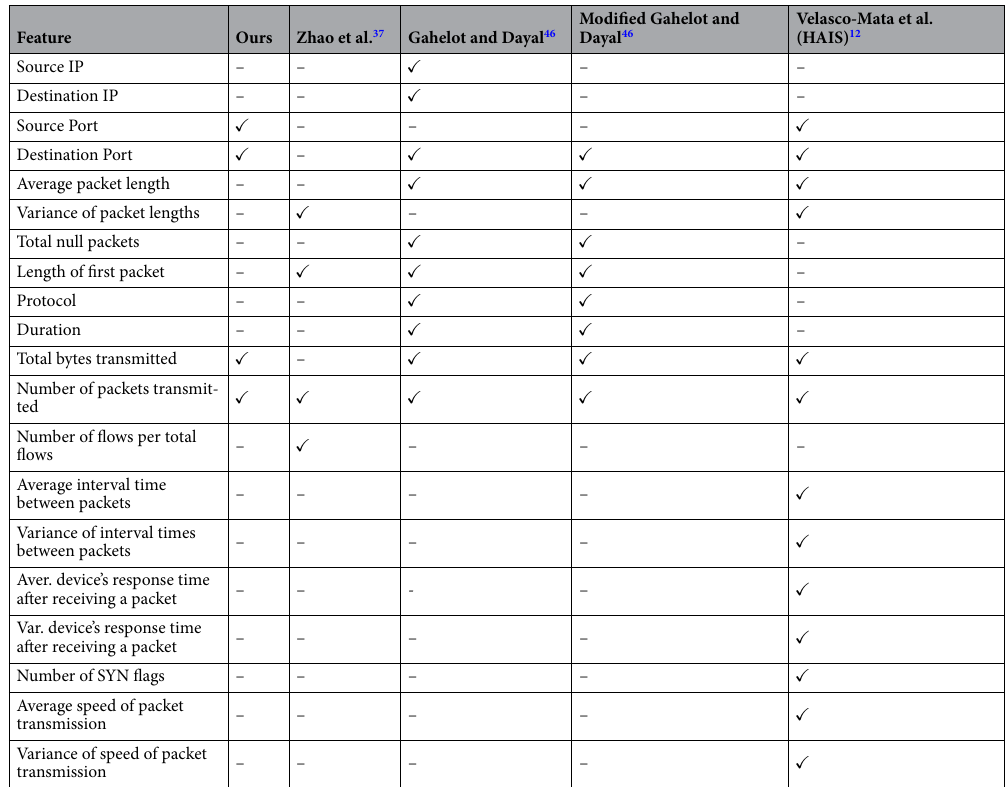
Table 1. Features used by the different models tested with time windows of one